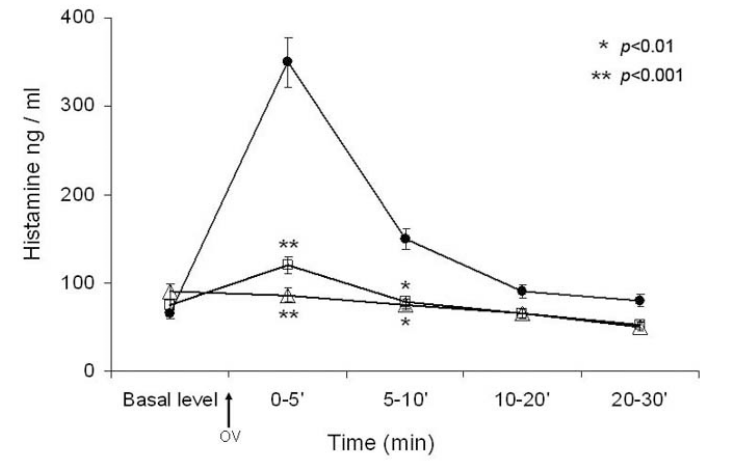
FIGURE 1 . Histamine release in the perfusates from untreated control hearts ( • ) and from hearts perfused with free ( (cid:133) ) or immobilized ( Δ ) histaminase (4 IU/ml). Data are expressed as mean ± SEM of eight